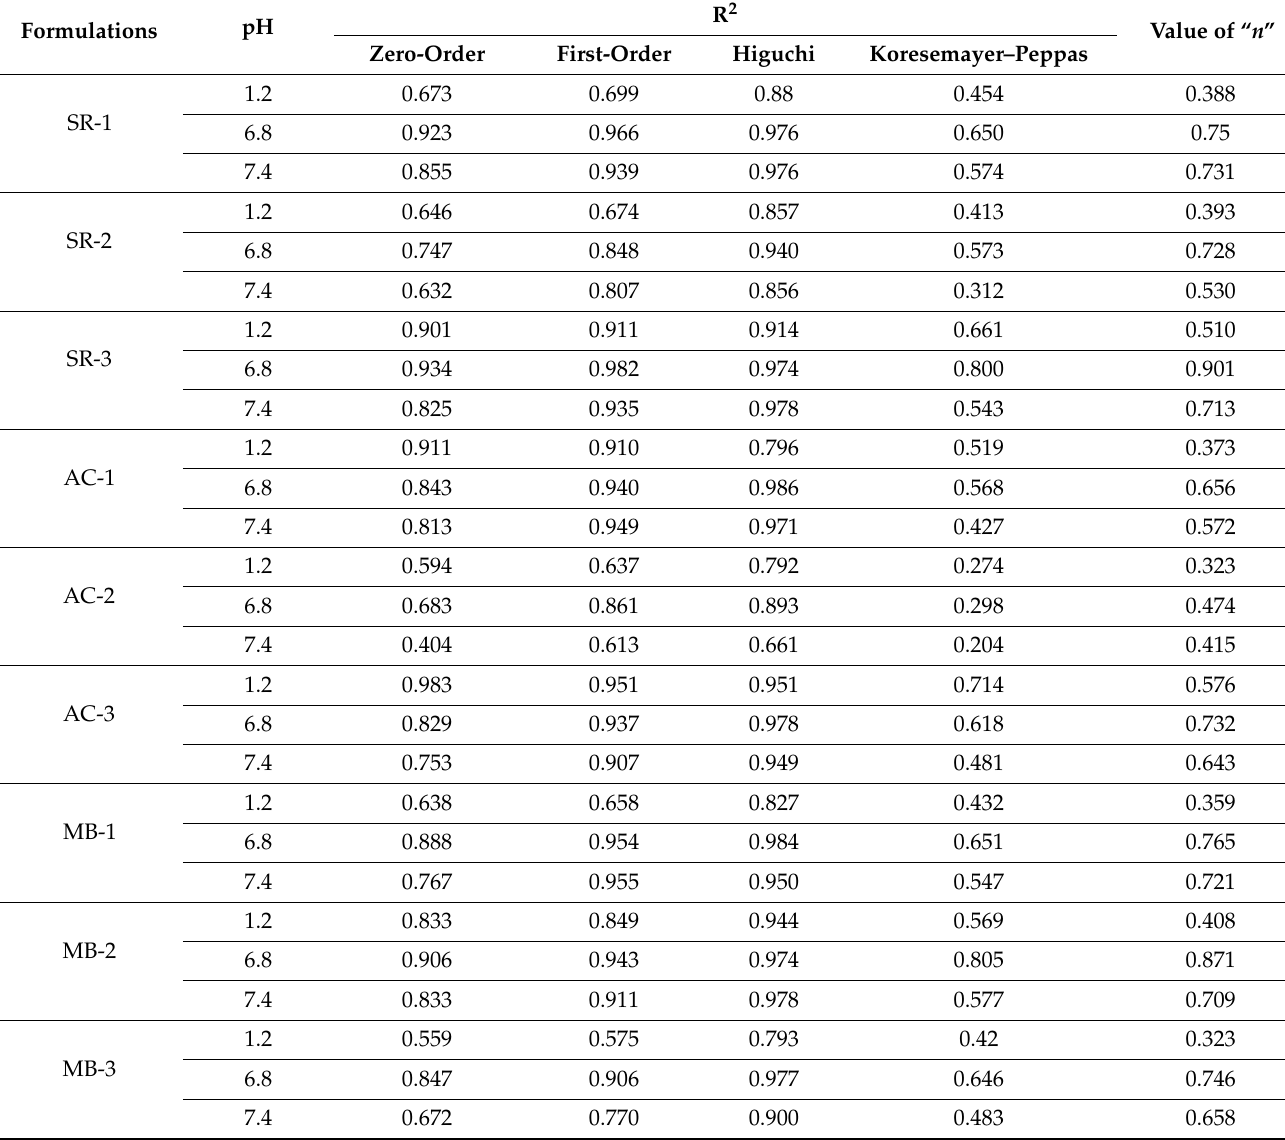
Table 2. Drug release kinetic models of all formulation of hydrogels having a variable concentration of sericin, acrylic acid, and